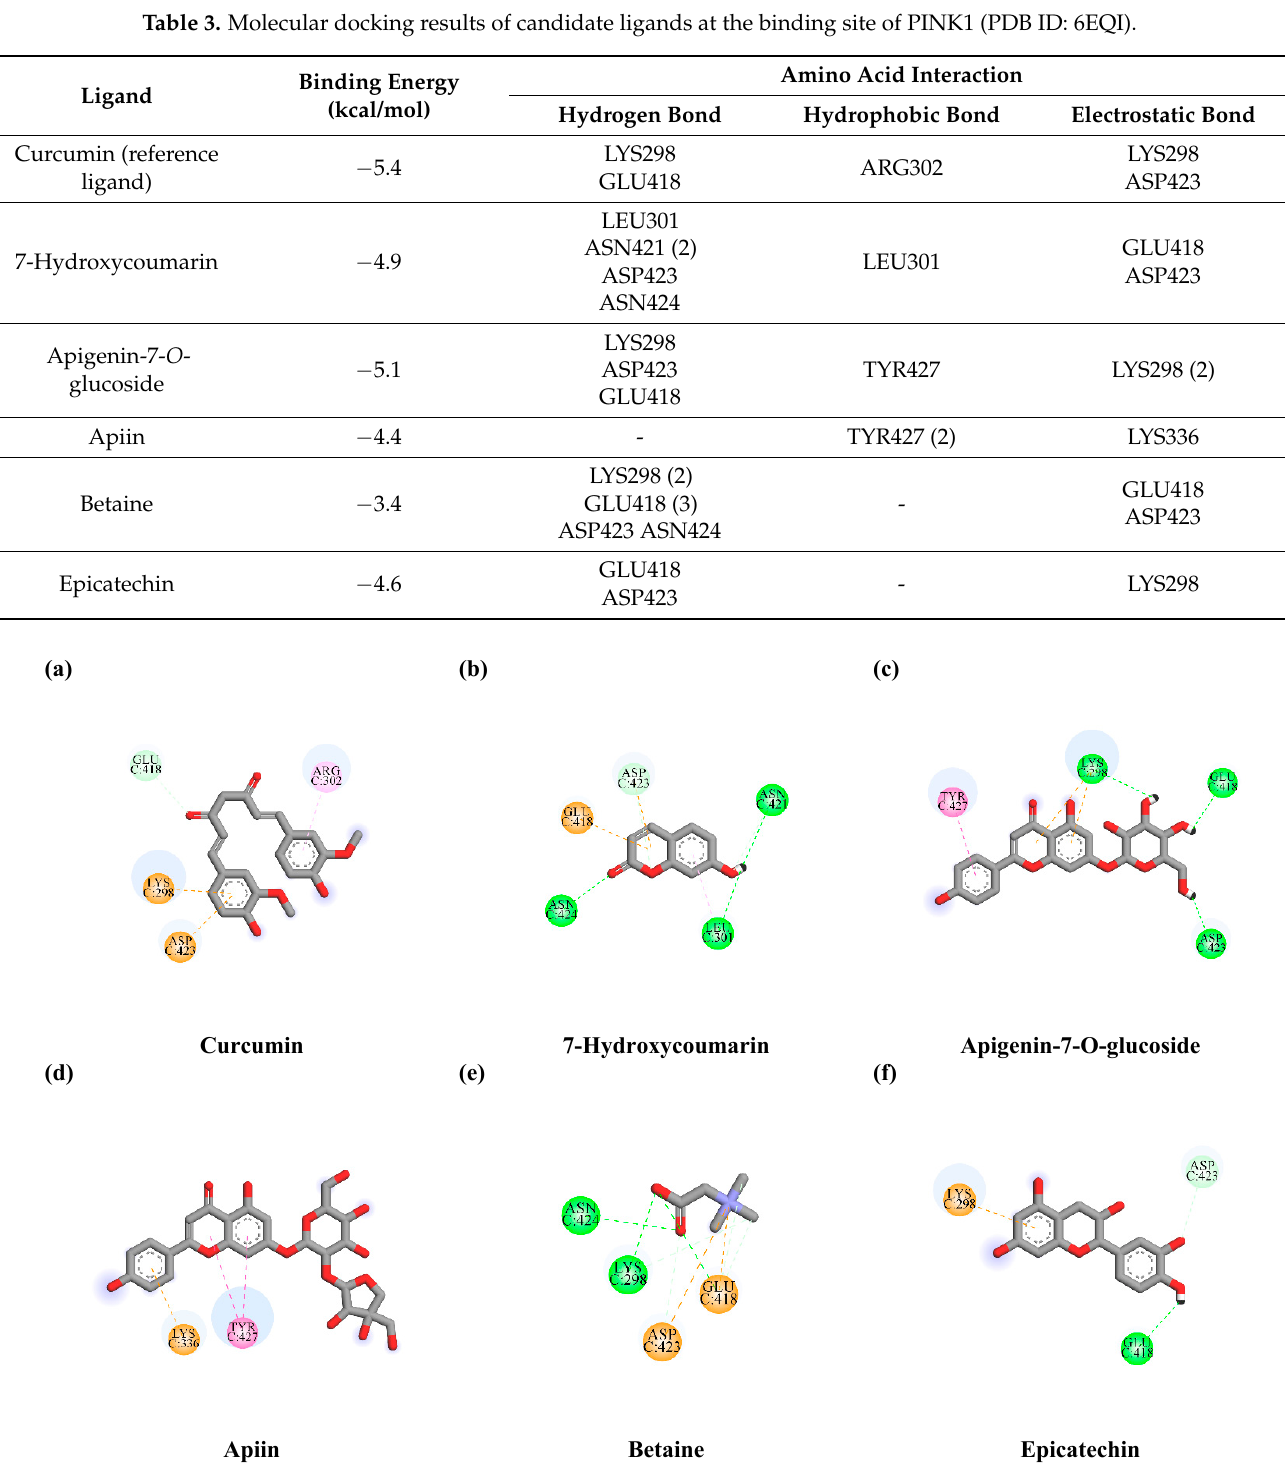
Figure 8. Schematics of amino acid interactions of PINK1 and candidate ligands: ( a ) curcumin, ( b ) 7-hydroxycoumarin, ( c ) apigenin-7- O -glucoside, ( d ) apiin, ( e ) betaine and ( f ) epicatechin. Green, pink and orange dashes indicate hydrogen, hydrophobic and electrostatic bonds,